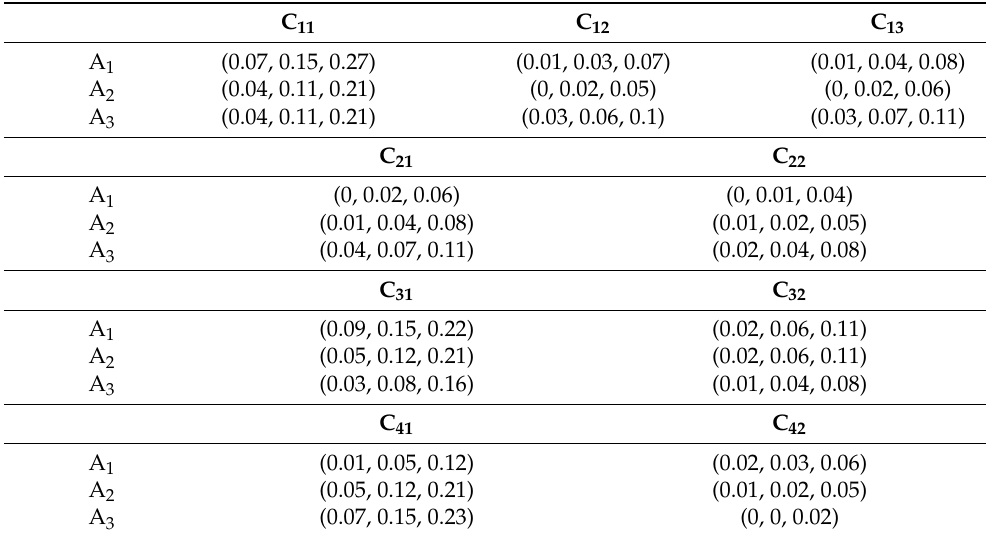
Table 10. Weighted normalized decision matrix.